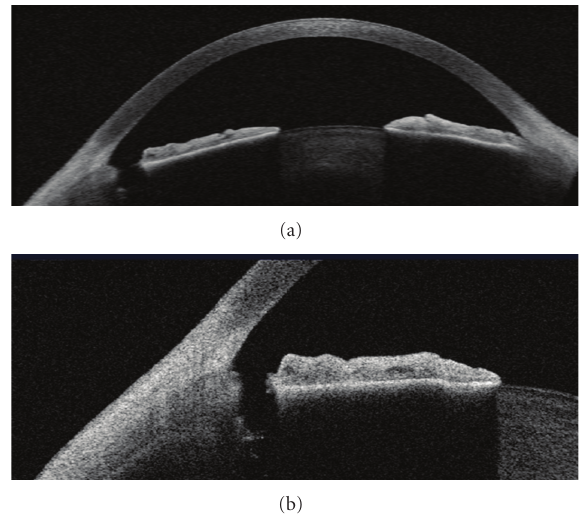
Figure 5: Patent peripheral iridotomy with AS-OCT. (a) shows enhanced anterior segment image with patent peripheral iridotomy and (b) shows raw mode and high-resolution image of cross-section through the anterior chamber with patent peripheral iridotomy.